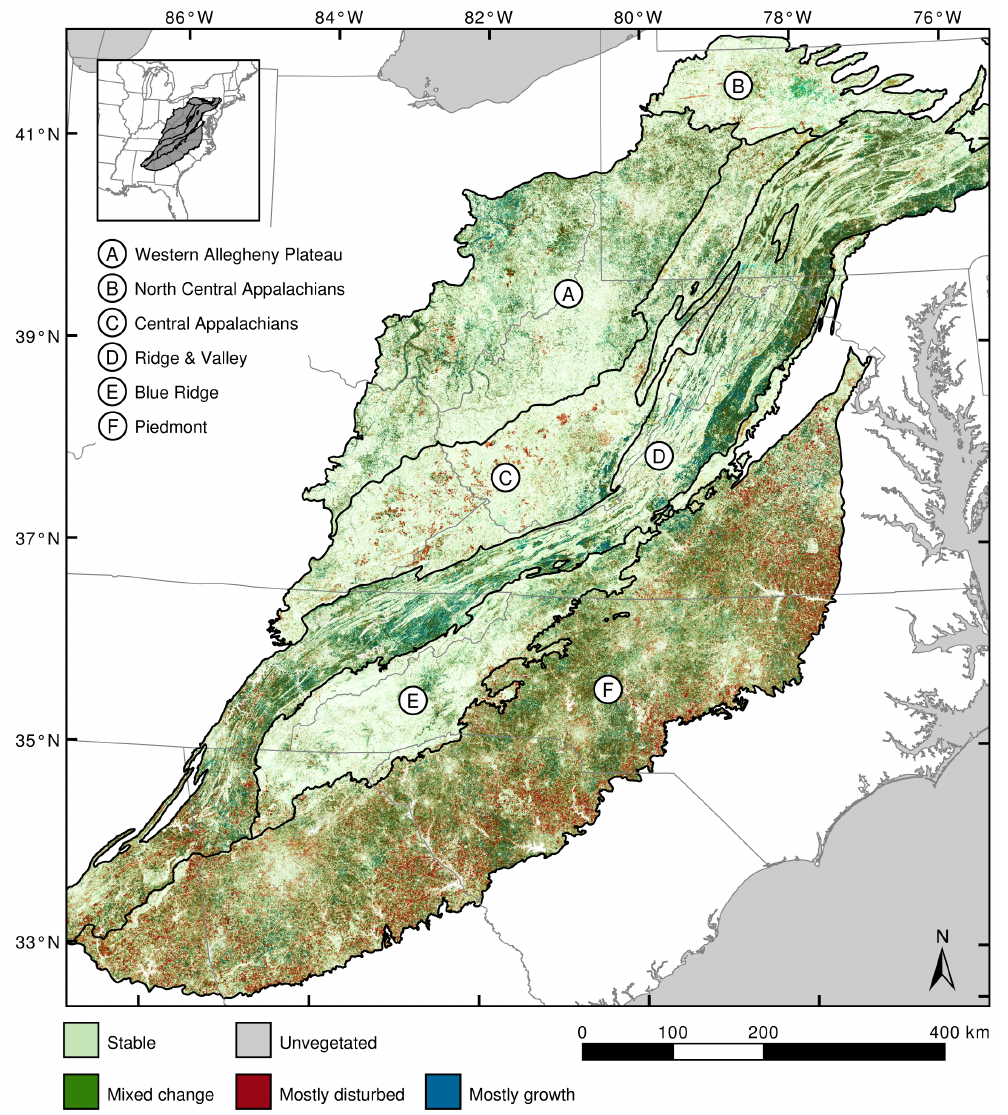
Figure 10. Changescape of forests in the Eastern United States over 28 years. Darker areas experience more frequent and intense change than lighter areas, which have primarily stable time series. Red areas experienced primarily disturbance, with dark red areas having sudden intense disturbances and lighter red areas exhibiting stress. Blue areas experienced primarily growth, typically regeneration from a previous disturbance, and green areas experienced a balanced mix of disturbance and regeneration likely due to agriculture or timber